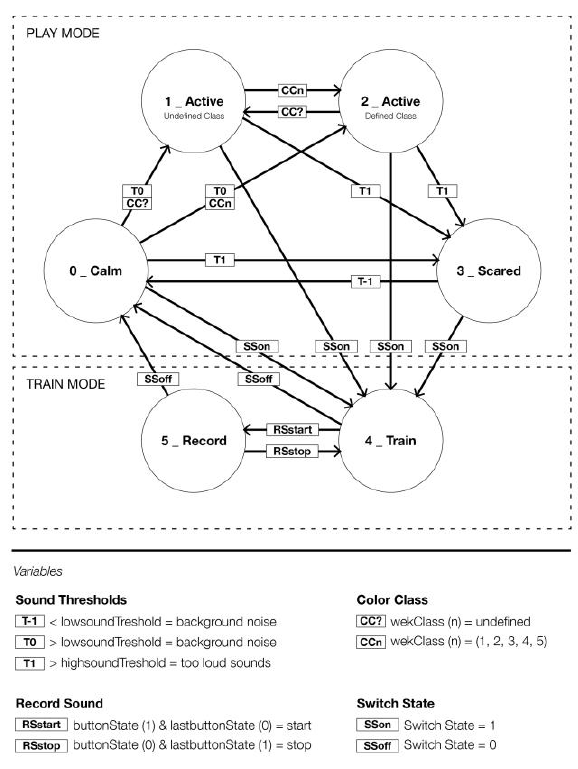
Figure 13 | Finite states